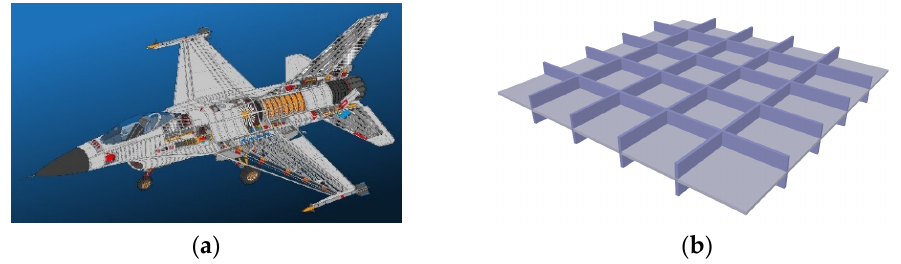
Figure 3. ( a ) Single-sided structures in an F-16 (Photo from (https://commons.m.wikimedia.org/wiki/File:Cutaway_drawing_of_an_F-16.jpg, accessed on 27 October 2021)) and ( b ) double-sided stiffened structures.